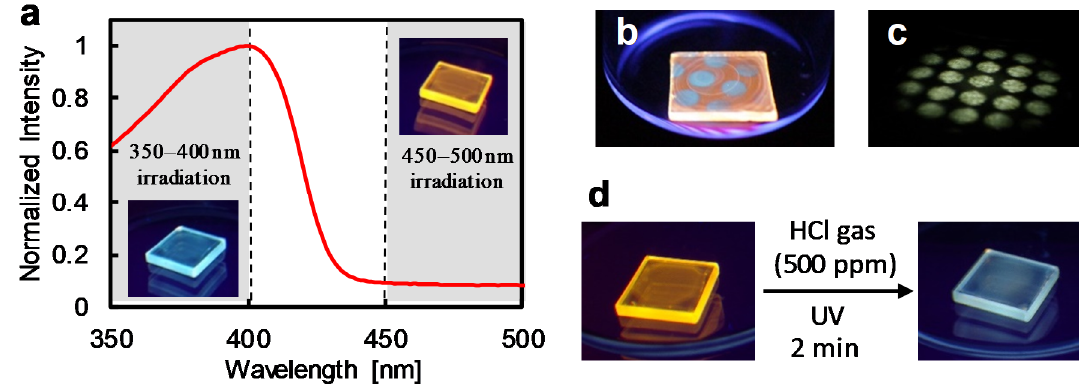
Figure 4. Experimental results of light-induced acceleration of polymer 1 film on SiO 2 substrate: ( a ) Photographic images (upon 365-nm excitation under deoxygenated conditions): Resultant substrate after 5% v / v HCl exposure for 5 min with UV irradiation of each wavelength range and an absorption spectrum of 1 in dilute CHCl 3 . ( b ) Photographic images (upon 365-nm excitation under deoxygenated conditions) of the resultant film with spot irradiations (350–400 nm) and 10% v / v HCl gas. ( c ) Photographic image of irradiation pattern in ( b ) with white light on black paper. ( d ) Photographic images (upon 365-nm excitation under deoxygenated conditions) before and after reaction with 500-ppm HCl gas for 2 min using light-induced acceleration.